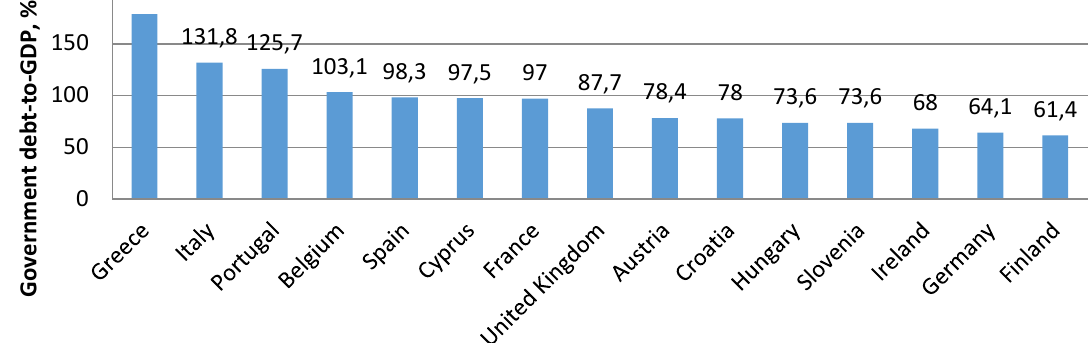
Figure 4. Countries-members of the European Union, which have the government debt-to-GDP rate higher than 60% (2017)